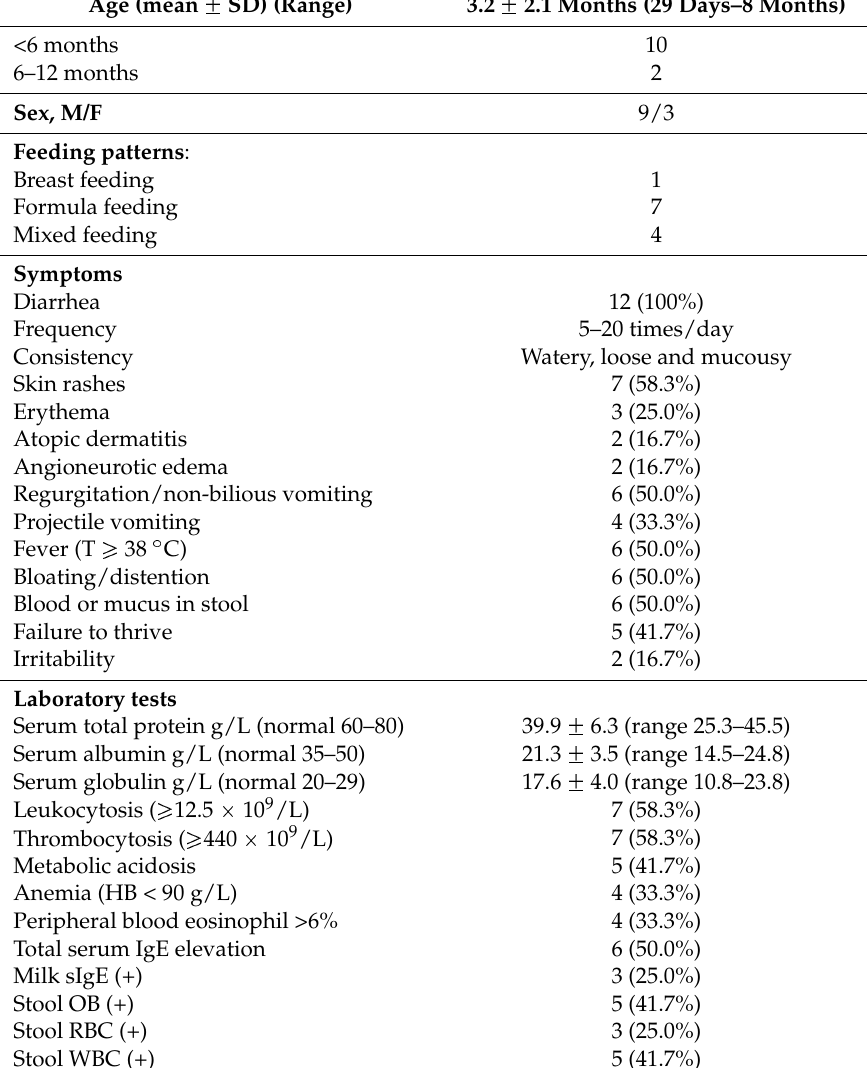
Table 1. Basic characteristics, clinical features and laboratory tests in infants with severe FPIES to cow’s